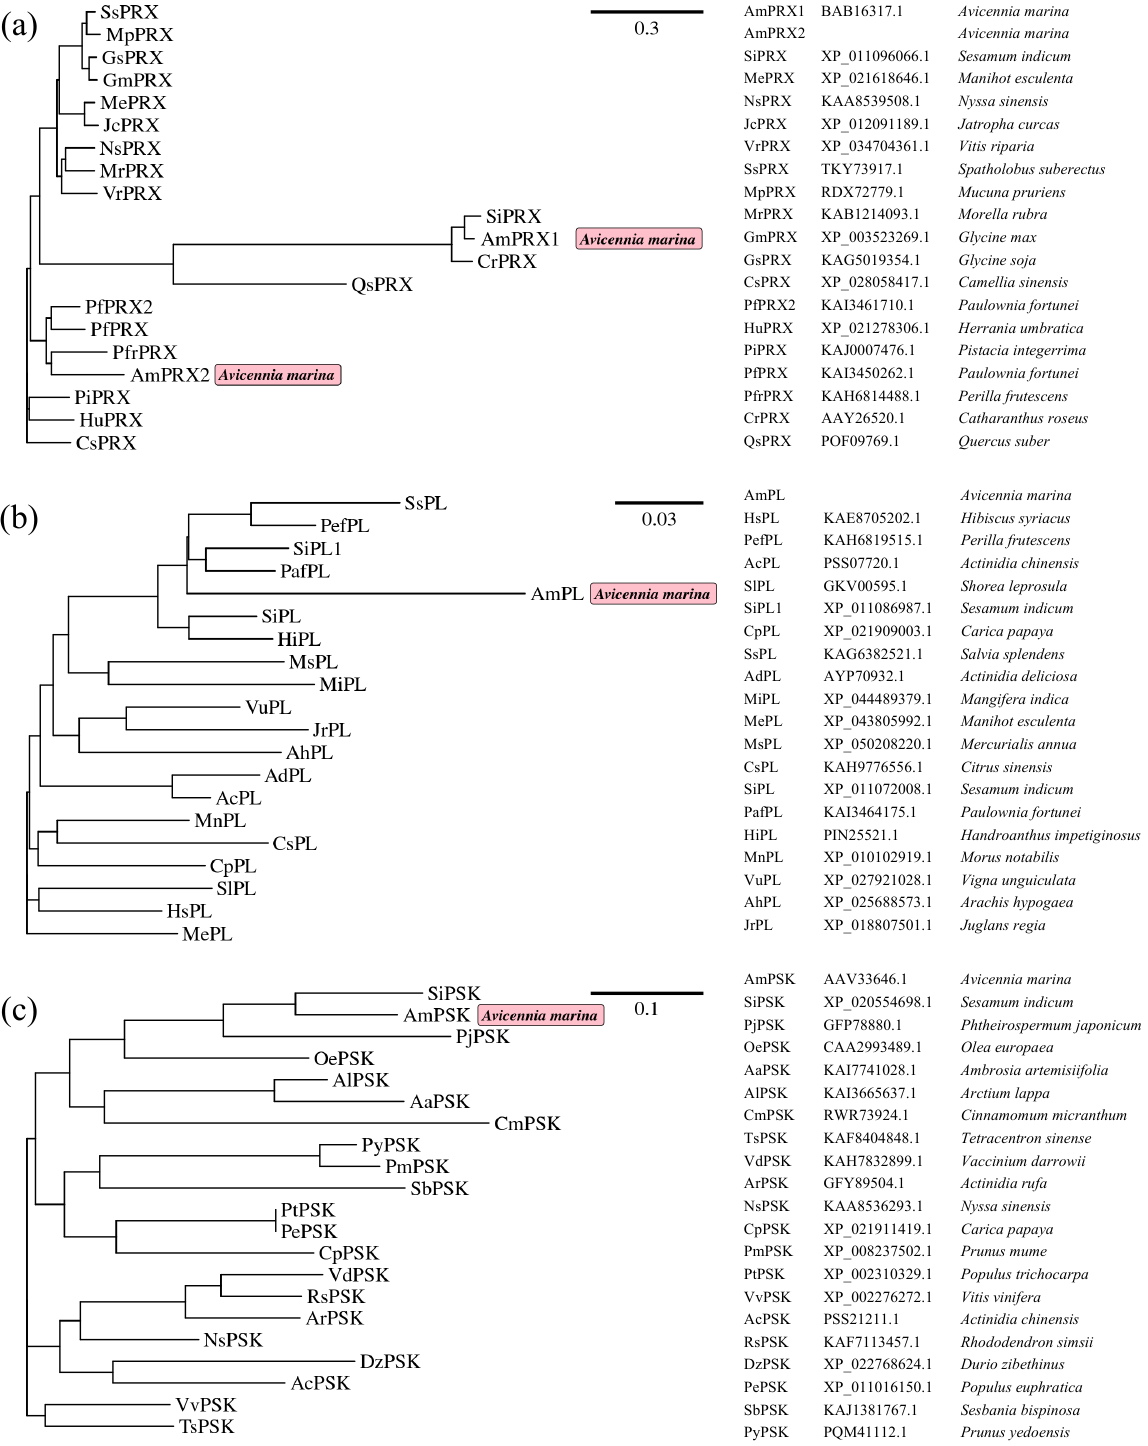
Figure 1. Phylogenetic tree generated using the ( a ) PRX, ( b ) PL, and ( c ) PSK proteins of various plant species. Abbreviations of 49 plant species and the GenBank accession numbers for each protein are shown in brackets.